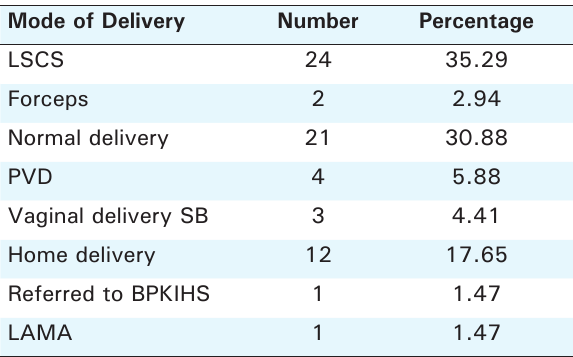
Table 6. Mode of